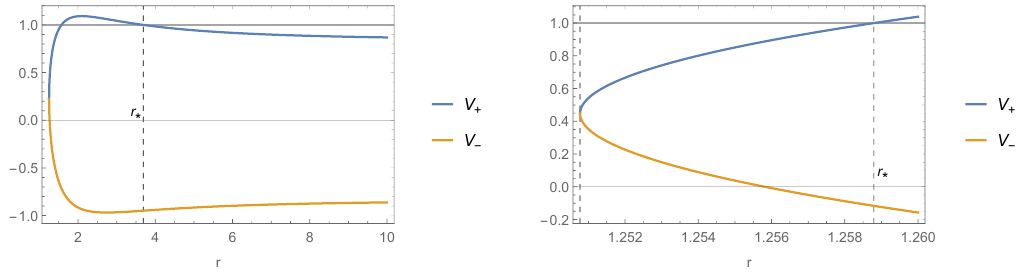
Figure 1. E(cid:11)ective potentials V (cid:6) ( r ) for a BH with: M = 1, ‘ = 3, a = 0 : 7, Q = 0 : 3 and impact parameters (cid:16) = 0 : 5 a) b = 2 : 5: the particle reaches the turning point r (cid:3) and returns to in(cid:12)nity b) b = 8 > ‘ . Motion is allowed only inside a (cid:12)nite region of the space and geodesics always fall into the